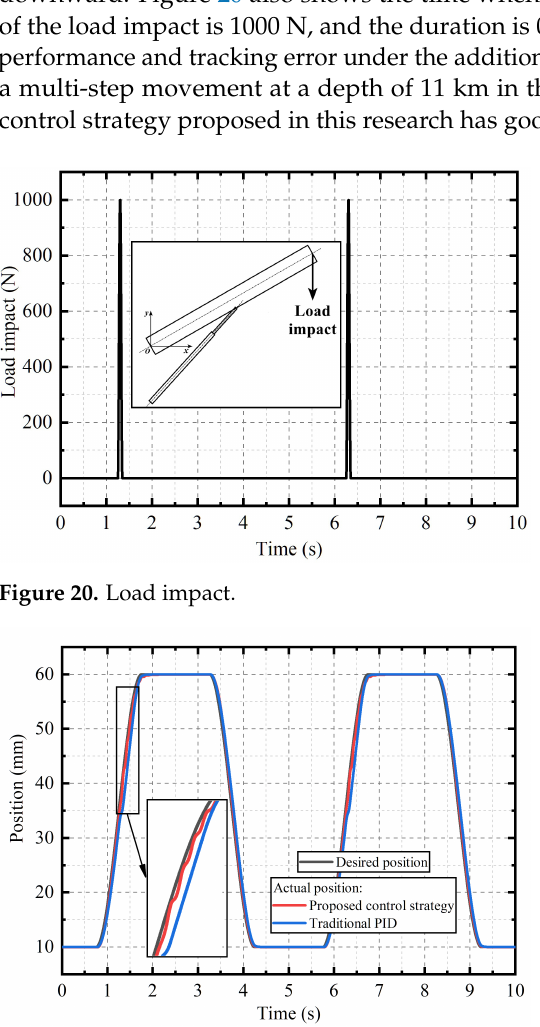
Figure 21. Tracking performance under load